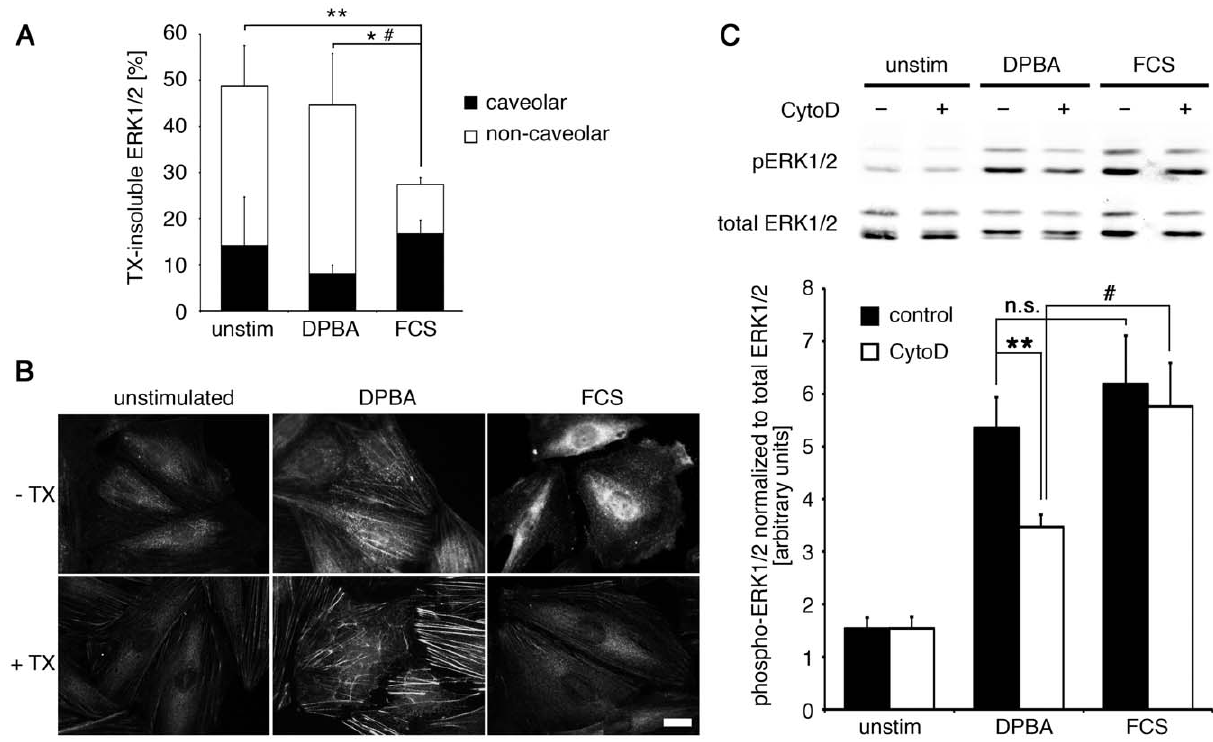
Figure 5. The cytoskeletal fraction of ERK1/2 is mobilized upon FCS, but not DPBA, stimulation. (A) A7r5 cells were treated with either DPBA or FCS and then subjected to subcellular fractionation into cytoskeletal and soluble fractions by Triton X-100 extraction. ERK1/2 subcellular distribution was analyzed by western blotting and densitometry. The graph shows the percentage of total ERK1/2 found in the caveolar and non- caveolar (cytoskeletal) TX-insoluble fractions at late time points of stimulation (30 minutes and 60 minutes). Statistical significance was tested by two- tailed Student’s T-Tests (non-caveolar insoluble fraction: *p , 0.05 DPBA vs. FCS, **p , 0.01 unstimulated vs. FCS; caveolar insoluble fraction: # p , 0.05 DPBA vs. FCS). (B) A7r5 cells were grown on coverslips were subjected to TX extraction before fixing and staining for phospho-ERK1/2. Please note that filamentous phospho-ERK1/2 staining after DPBA stimulation is TX resistant, while the nuclear and diffuse perinuclear phospho-ERK1/2 staining after FCS stimulation is not. Scale bar, 20 m m. (C) A7r5 cells, pretreated with Cytochalasin D for one hour or control treated (solvent only), were stimulated with either FCS or DPBA, or left unstimulated, for another hour. Lysates were subjected to western blotting with a total ERK1/2 antibody and a phospho-ERK1/2 antibody. The graph shows phospho-ERK1/2 relative to total ERK1/2. Statistical significance was tested by a paired